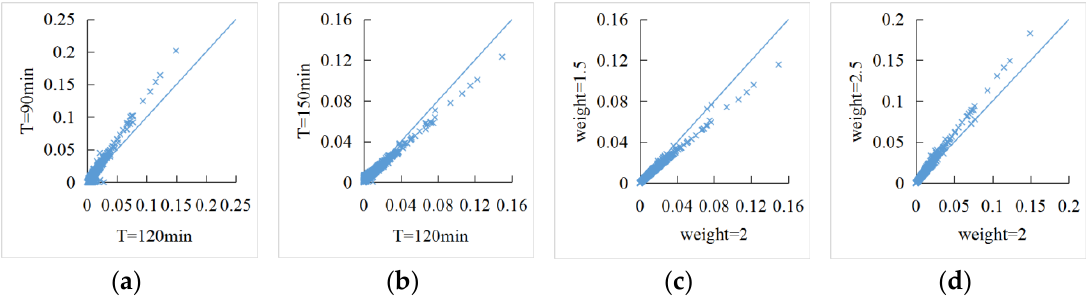
Figure 8. Comparisons of scatter plots of accessibility with different ( a , b ) service thresholds (T = 90 min, T = 150 min); ( c , d ) service-capacity weights (W = 1.5, W = 2.5).